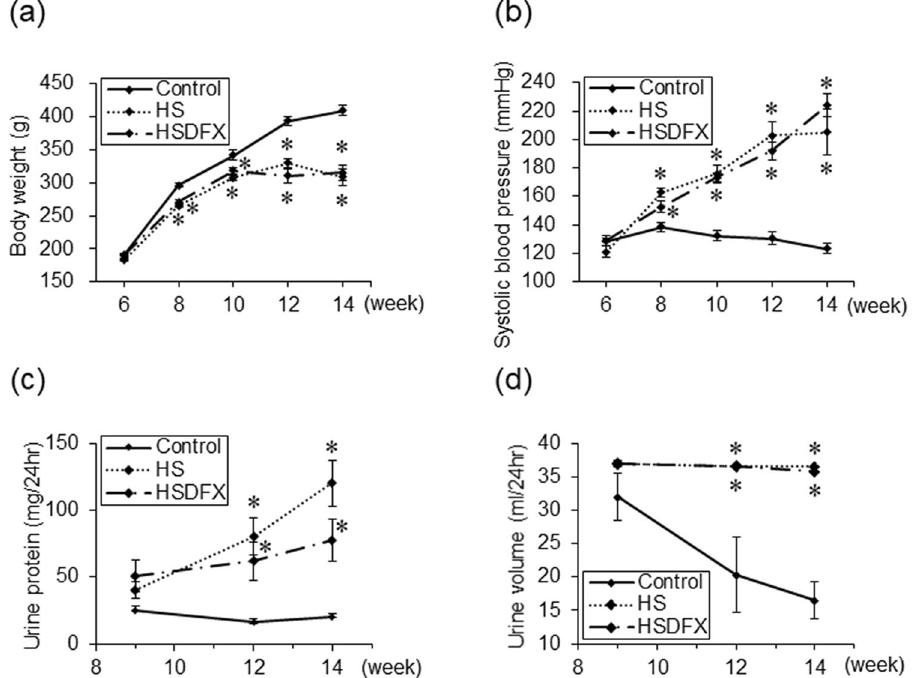
Figure 5. Changes in physiologic parameters and urine-protein by administration of deferasirox. Body weight ( a ), Systolic blood pressure ( b ), Urine volume for 24 h ( c ), and Urine-protein for 24 h ( d ) in the control (n = 6), the HS (n = 6) and the HSDFX (n = 4) groups. Statistical analysis for each time-point was performed using one-way analysis of variance followed by Tukey–Kramer test in ( a ), ( b ), ( c ), and ( d ) by JMP Pro Version 14.2.0 software (SAS Institute Inc.). * p < 0.05 vs. the control